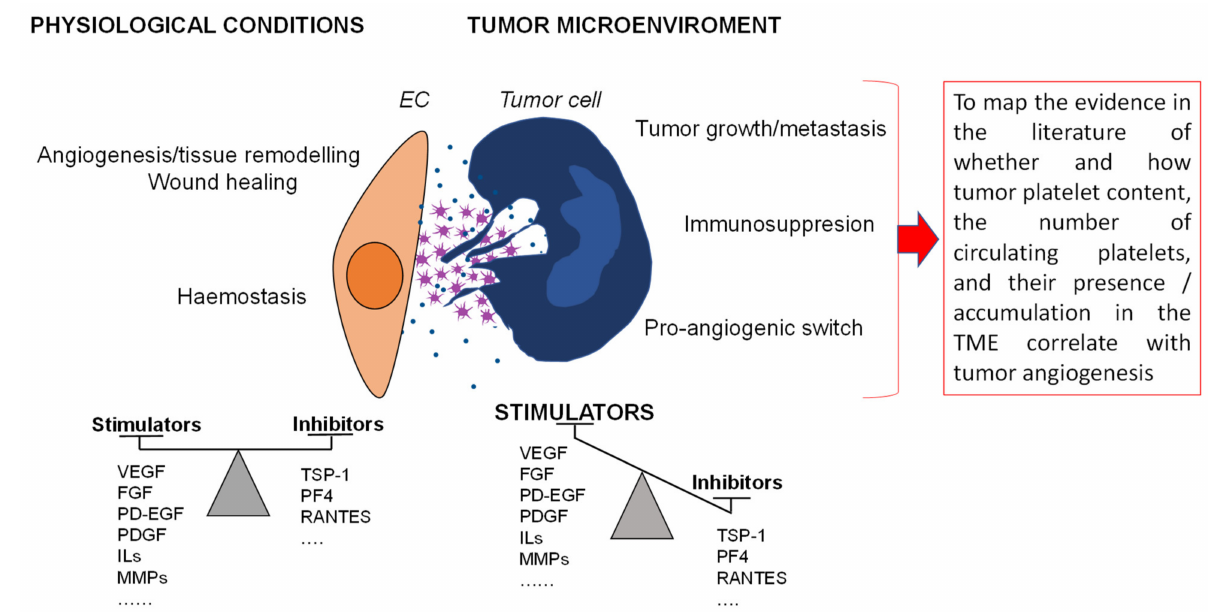
Figure 1. Representative scheme of the supporting role of platelets in tumor progression. Platelets play an important physiological role in hemostasis and wound repair and, in the tumor microenviron- ment, interacting directly with the vascular and tumor components support through the accumulation and release of growth and angiogenic factors tumor progression. Platelets; growth/inhibitory